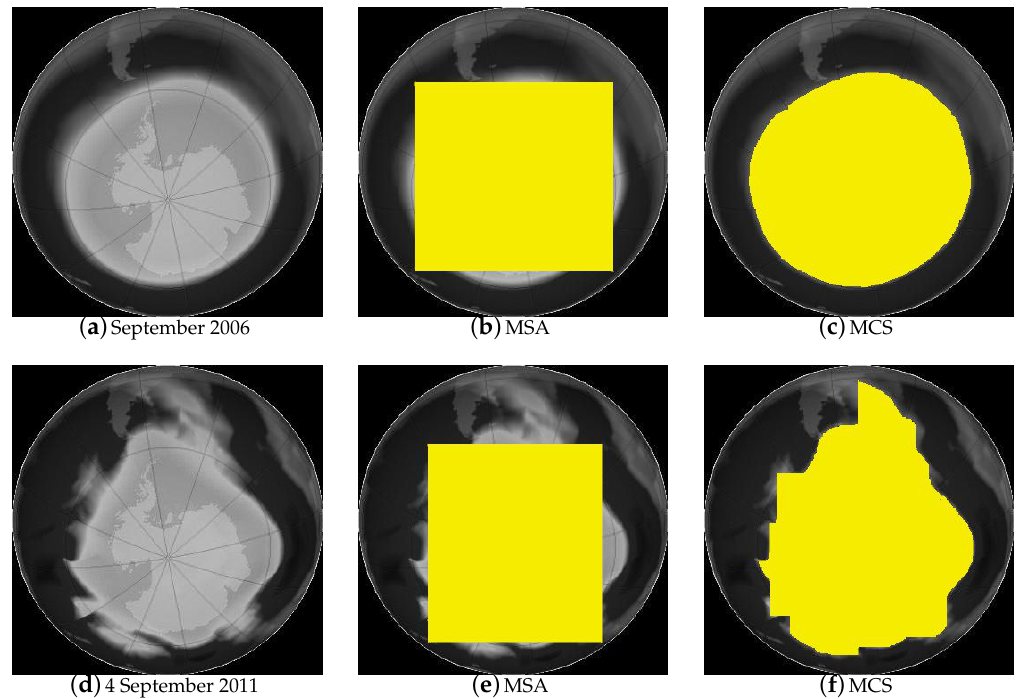
Figure 1. Ozone hole identified by the maximum subarray (MSA) and maximum convex sum (MCS) algorithms (Courtesy of